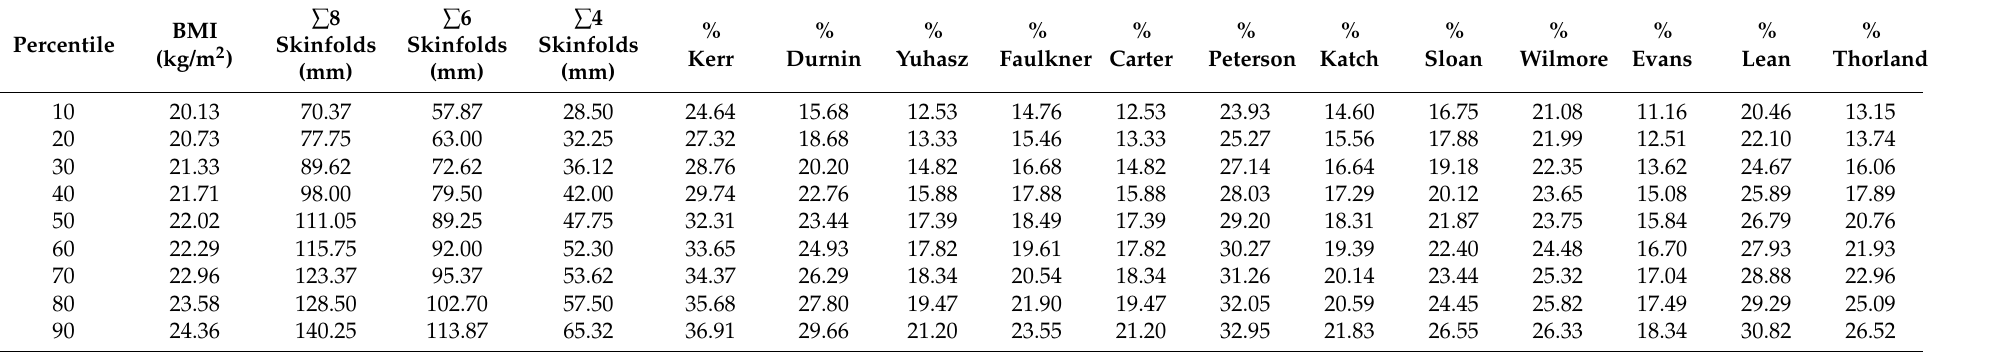
Table 9. Percentile relationships between BMI, skinfold sum, and adiposity formulas in